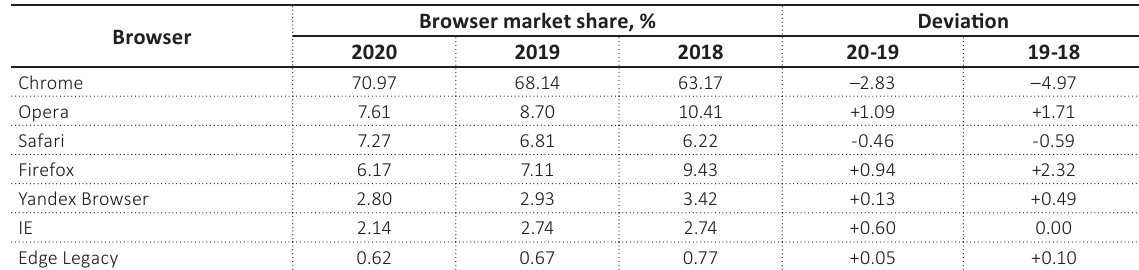
Source: Built based on StatCounter (n.d.).